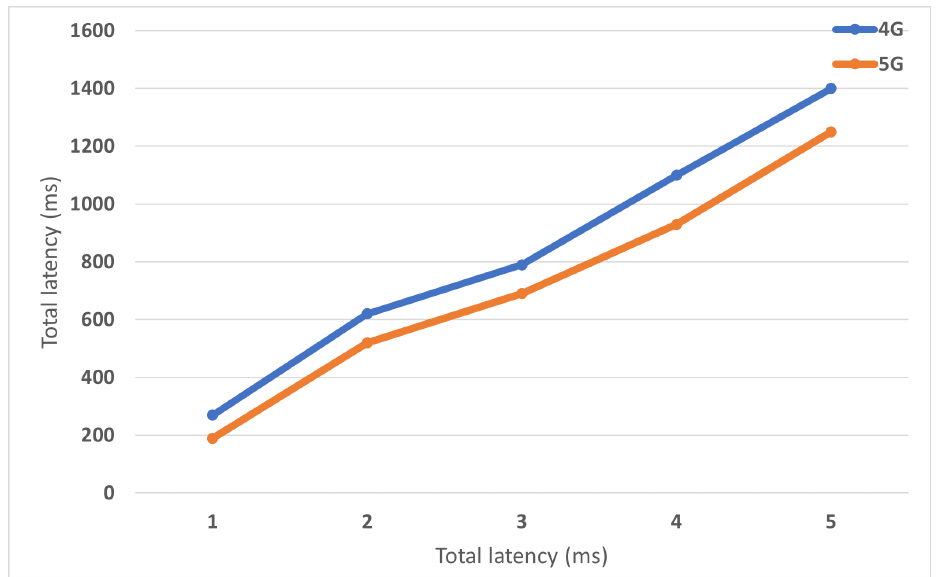
Figure 18. Comparison of 4G and proposed 5G in terms of latency of Inter-Handover with eNB per